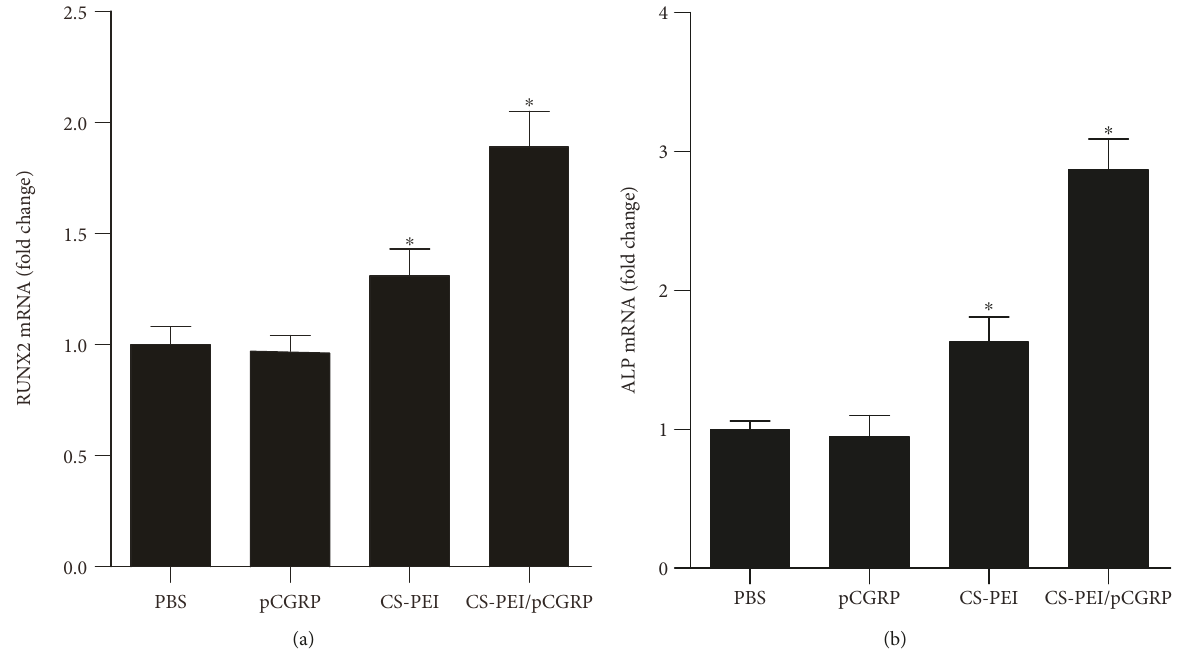
Figure 8: RUNX2 and ALP mRNA levels in the callus of rat femoral fracture model after a 3-week treatment with CS-PEI/pCGRP. Data are mean ± standard deviation ( n = 4 ). ∗ P < 0 05 vs. the PBS group.